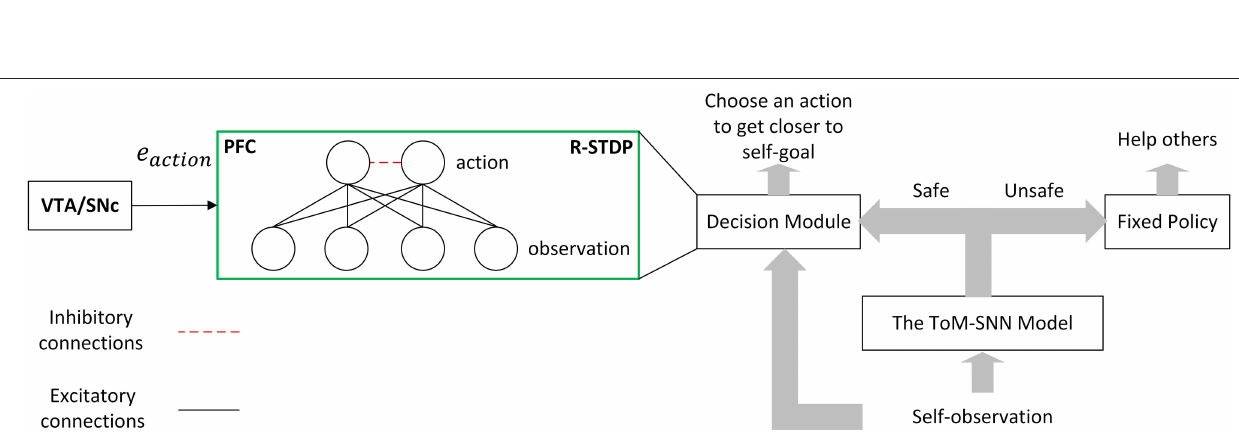
FIGURE 3 | Simple architecture for reducing the safety risks of others. The ToM-SNN model can infer others’ safety status by inferring their beliefs and behavior styles. The agent will continue carrying out its task when others are in a safe situation, whereas it will help with fixed policy when others are unsafe. The arrow in the figure indicates information transmission and does not involve the learning of network